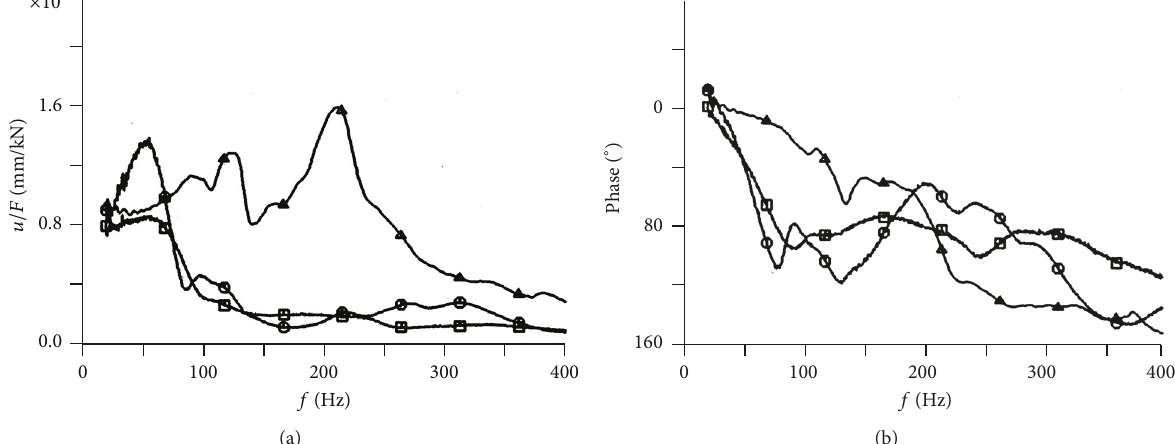
Figure 5: Transfer functions of the tracks of the ◻ surface, I bridge, and △ tunnel line and amplitude and phase of the rail receptance above the